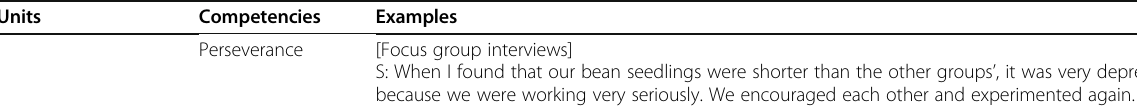
Table 4 Results of categorizing the data (Continued) Units